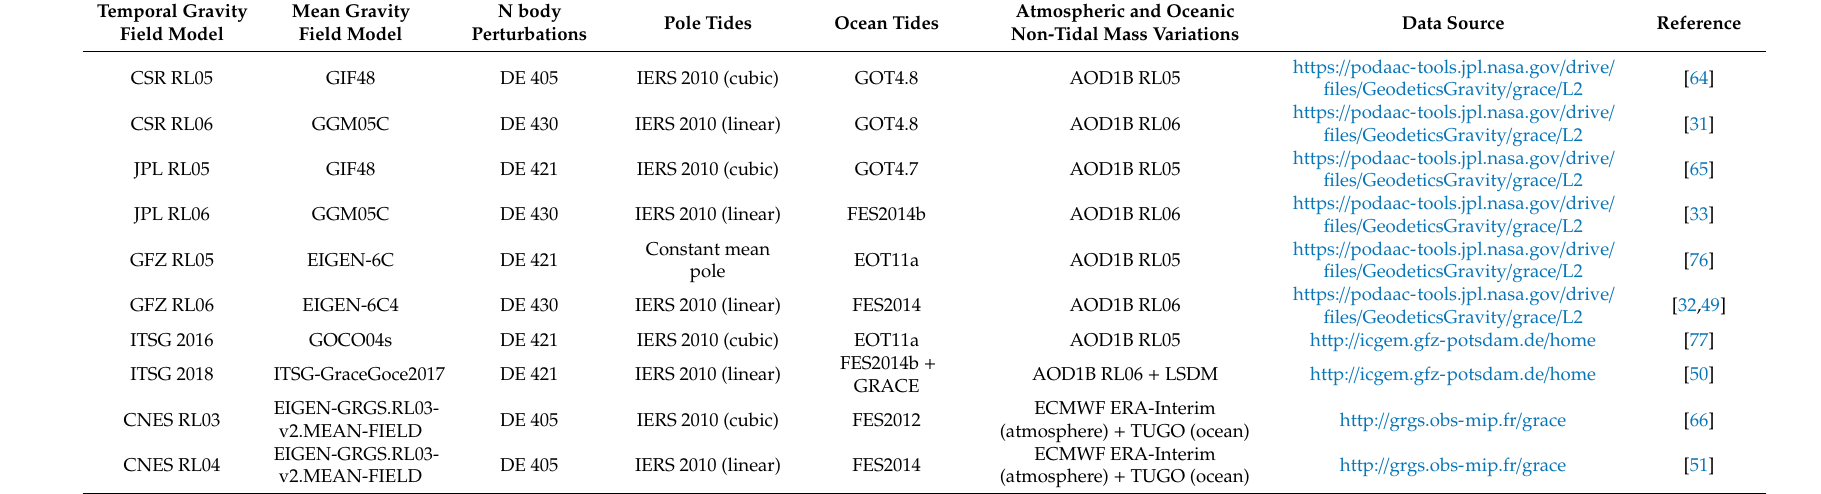
Table A1. Background models, data sources, and references for temporal GRACE gravity field